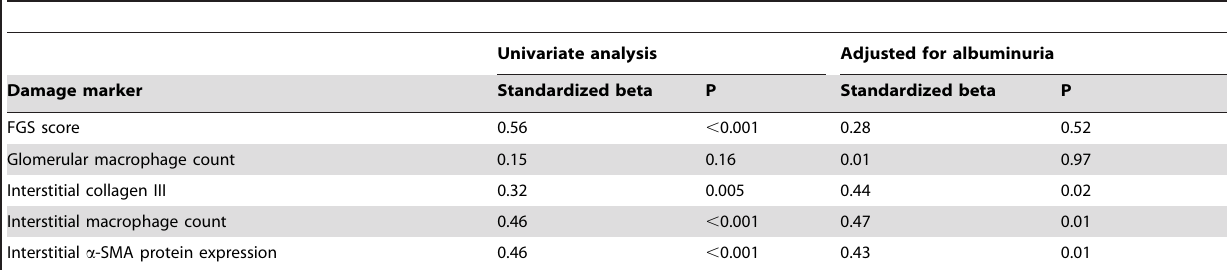
Table 2. Associations of urinary VDBP with renal histological parameters in the affected kidney in the rat unilateral adriamycin nephropathy model.